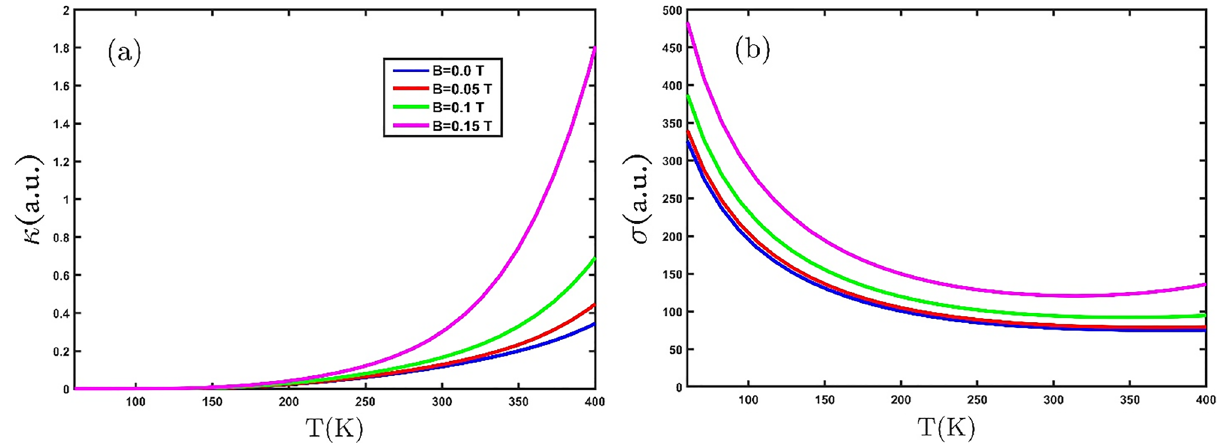
Figure 7. ( a ) and ( b ) The electronic thermal and electrical conductivity in terms of temperature under the effect of various external magnetic fields, respectively.